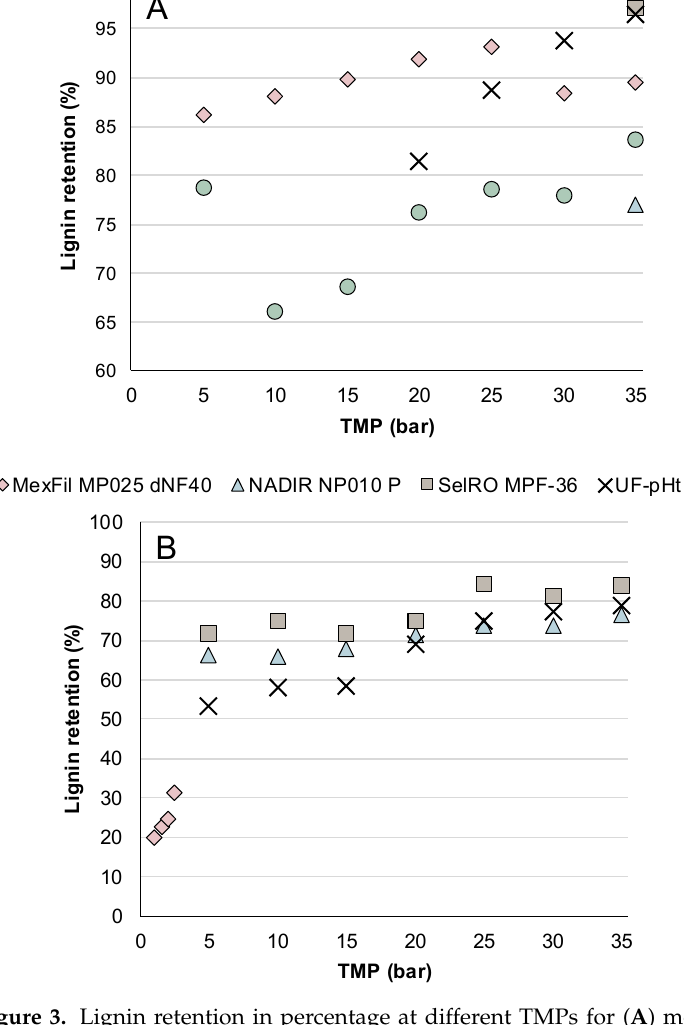
Figure 3. Lignin retention in percentage at different TMPs for ( A ) membranes NanoPro B-4021, NanoPro B-4022, NF090801, NADIR NP030 P, and SelRO MPF-34, and ( B ) membranes SelRO MPF-36, NADIR NP010 P, UF-pHt GR95PP, and MexFil MP025 dNF40.